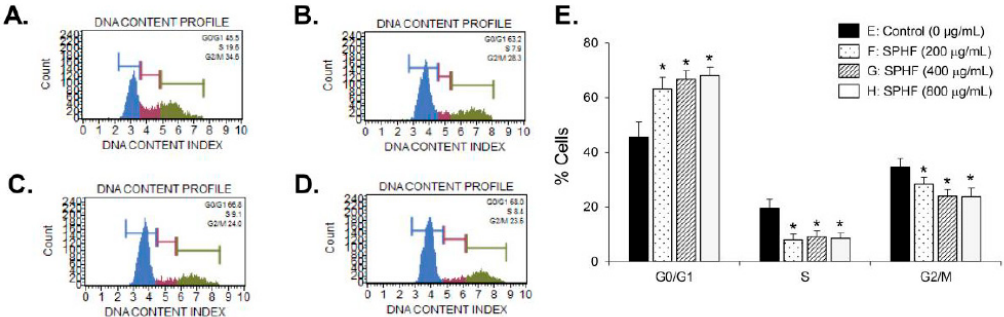
Figure 2. SPHF induced G1-phase cell cycle arrest in EJ cells. ( A – D ) FACS histograms of EJ cells followed by di ff erent SPHF treatment concentrations. ( E ) Cell cycle distribution in SPHF-treated cell populations. Values are presented as the mean ± SD of three independent experiments; * p < 0.05 relative to the non-treated